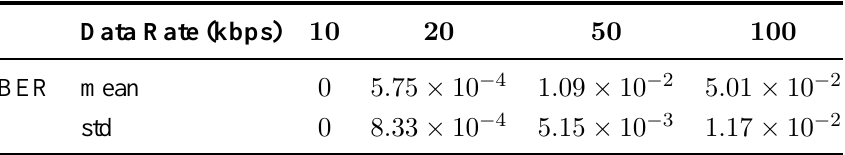
Table 2. Bit error rate (BER) obtained from